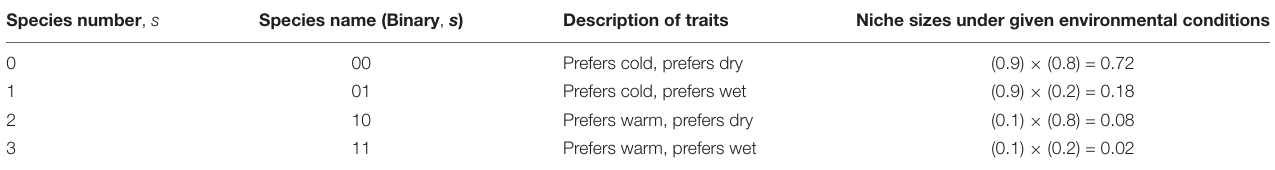
TABLE 1 | Niche representations for two niche factor axes ( K = 2) in the example of Figure 1 and the corresponding niche sizes when the environment is warm and moist. Species number , s Species name (Binary , s